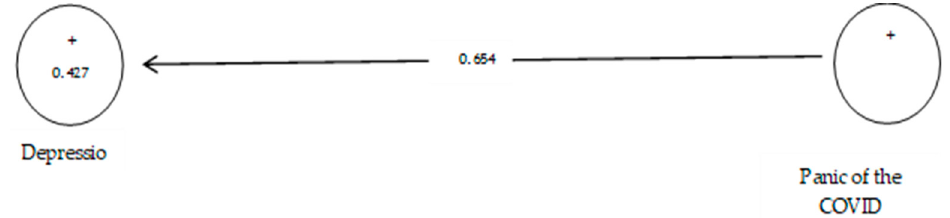
Figure 20. The ninth sub-hypothesis model includes factor load coefficients.